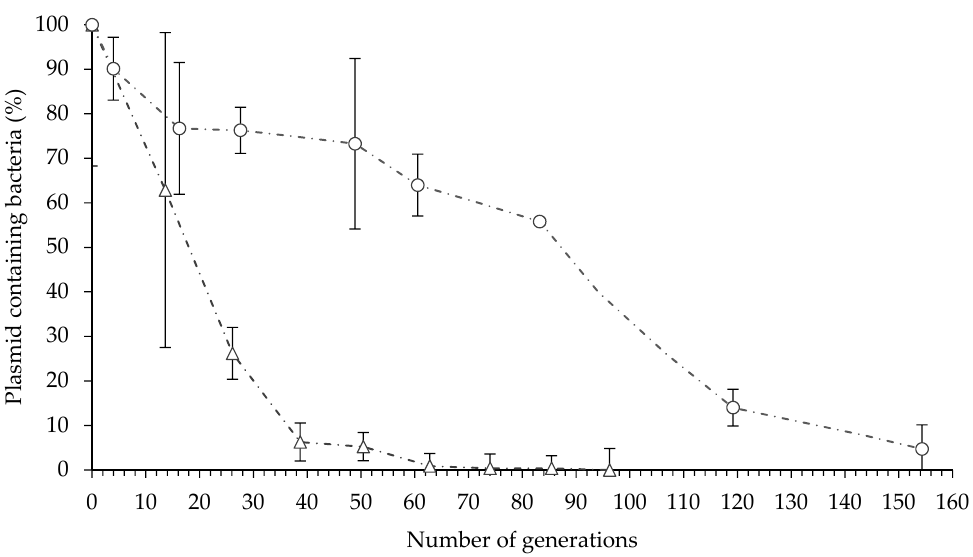
Figure 2. In vitro plasmid maintenance in E. billingiae / pNmI (white circles) and B. simplex / pNF8 (white triangles). Error bars indicate the standard deviation of four biological replicates.